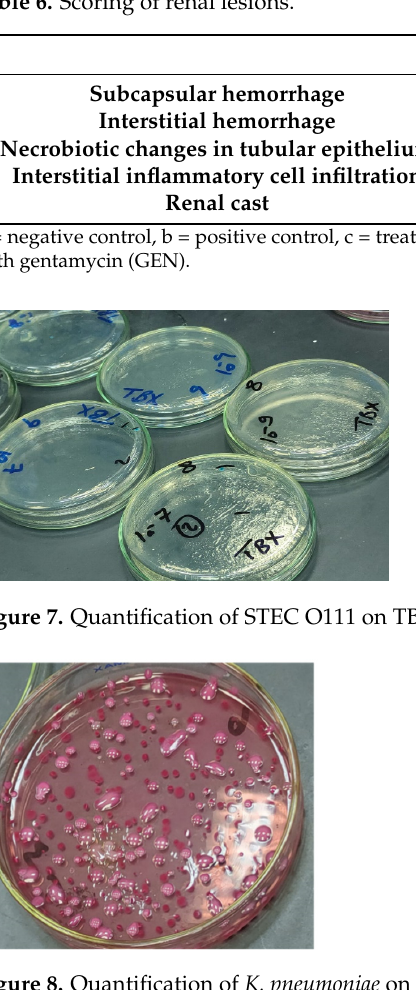
Table 6. Scoring of renal lesions.